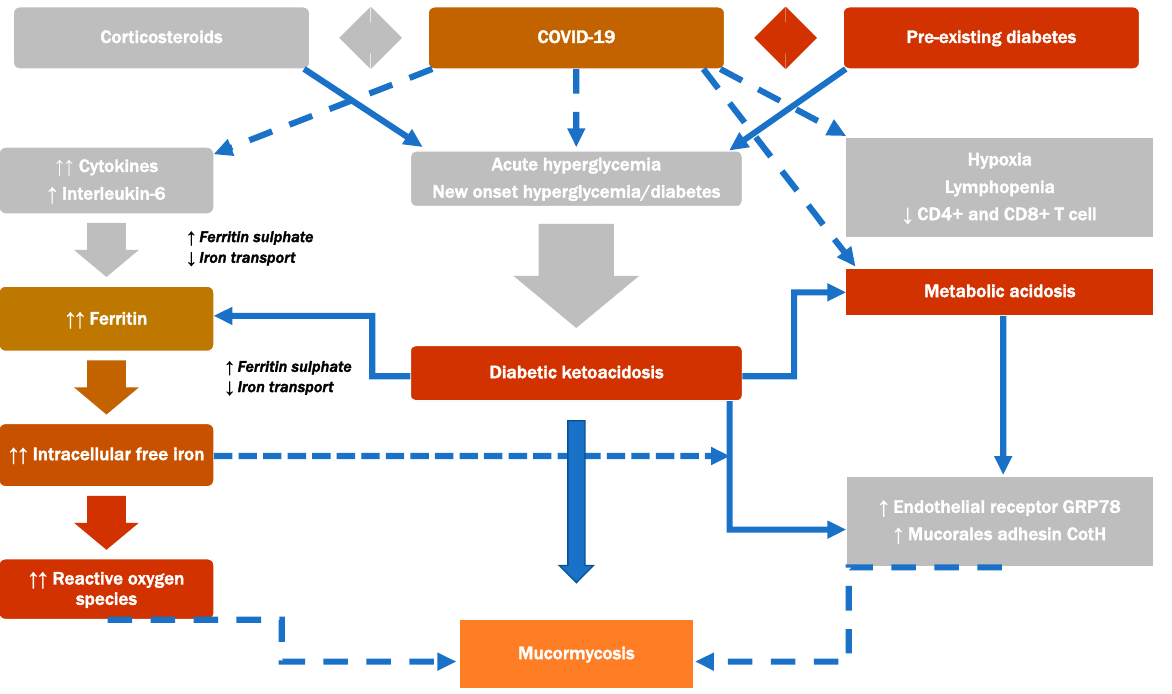
Figure 2. Association of diabetes, corticosteroid, and COVID-19 with mucormycosis. Reprinted with permission from ref. [67]. Copyright Year (2021) Copyright Owner’s Name (Elsevier).